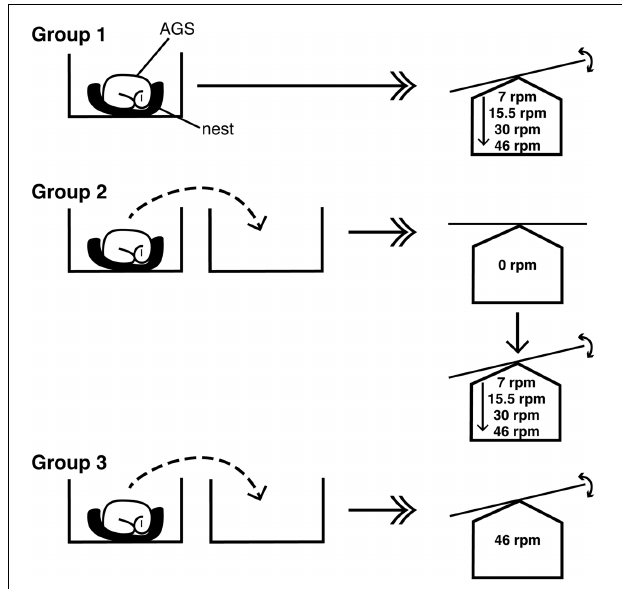
FIGURE 1 | Schematic diagram of exposure of AGS to handling and movement. Group 1 AGS were left in their home cage, which was placed on a platform rocker (indicated by double arrowhead), at a rocker rate of 7rpm (movement indicated by double-headed curved arrow) for 2min. This was repeated daily until animals had an increase in RR of ≤ 1 at 5 and 30min after initiation of movement, for 3 consecutive days (i.e., one session per day). Animals were exposed to increasing rocker rates at frequencies of 15.5, 30, and 46rpm increasing in a stepwise fashion (solid arrow). Group 2 AGS were handled with the researcher picking them up their cotton cup-like nest and transferring them to a new cage (dashed curved arrow), which was placed on a platform rocker, without any additional movement (i.e., 0rpm). This was repeated daily as described for group 1 until AGS did not respond to this handling (change in RR ≤ 1) for 3 consecutive days. AGS were then handled as above but the new cage was then placed on the platform rocker for 2min with movement. The intensity of movement was increased in a stepwise fashion from 7, 15.5, 30 to 46rpm, once AGS did not respond to the stimuli (RR ≤ 1) for 3 consecutive days. Group 3 AGS were moved with their cotton cup-like nest to a new cage, which was placed on a platform rocker and exposed to a movement intensity of 46rpm for 2min. This was repeated daily as described for group 1 until AGS did not respond to handling (change in RR ≤ 1) for 3 consecutive